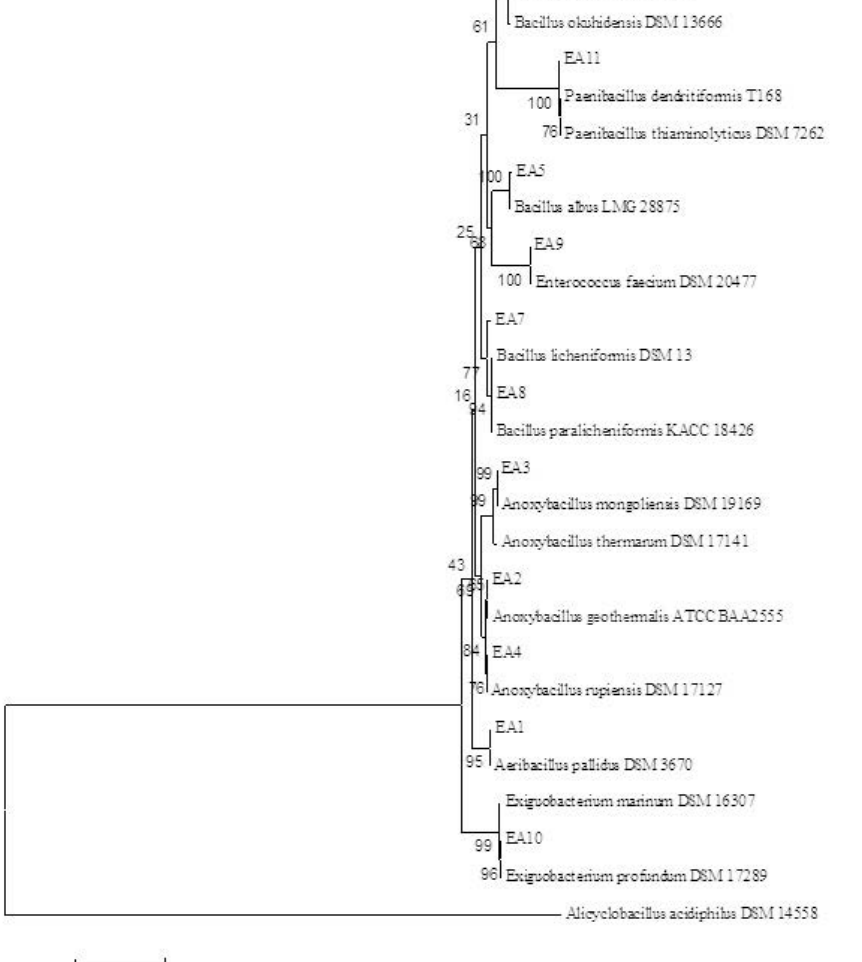
Fig. 3. Neighbor-Joining phylogenetic tree of thermophilic bacteria isolated from different hot springs of Turkey based on 16S rRNA gene analysis results. Alicyclobacillus acidophilus used as an external